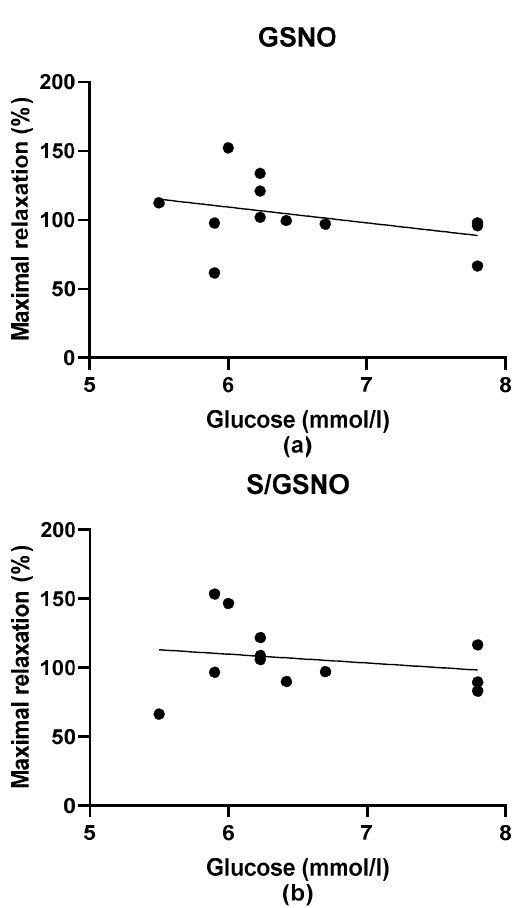
Figure 9. The mutual relationship between plasma glucose levels and the maximal relaxation induced by GSNO ( a ) and S / GSNO products ( b ). There was no dependency in this respect for both GSNO and S / GSNO products.